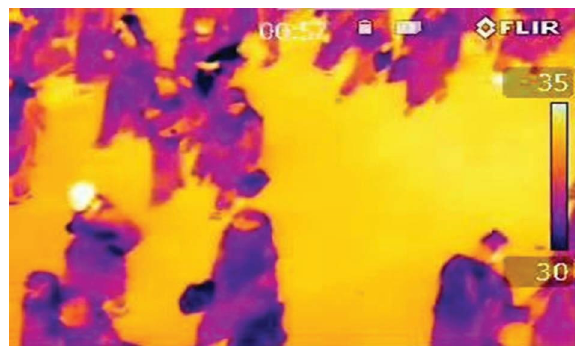
Figure 6: Te heat temperature representation of one frame scene extracted from thermal video.